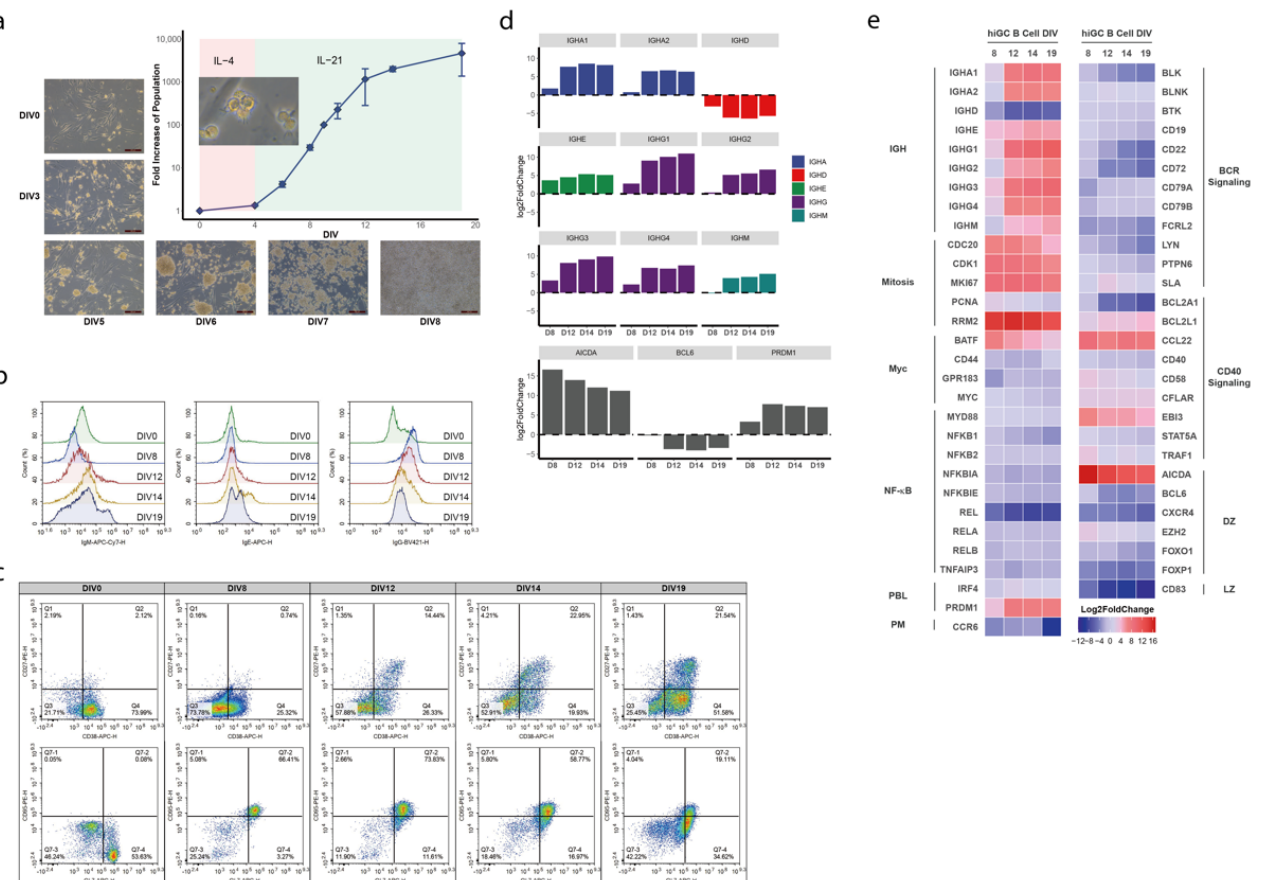
Figure 1. Phenotypic and molecular characterizations of the hiGC culture. ( a ) Growth curve and microscopic images of human in-vitro germinal center (hiGC) B cells co-cultured on the MRC40LB feeder layer. In the first phase of culture (days in vitro (DIV) 0–4), only IL-4 was added; the second phase of culture (DIV4-19) included additional IL-21 in the medium. The insert image in the growth curve plot is a 40× magnification of hiGC B cells exhibiting typical morphological changes upon activation. ( b ) Flow cytometry (FCM) plots showing the increase of IgM+, IgE+, and IgG+ cell populations. ( c ) FCM results showing the increase of CD27+/CD38+ and Fas+/GL7+ cell populations. ( d ) Heatmap of transcription levels for key B cell genes as a function of DIV in the hiGC co-culture. All transcription levels were normalized to those of the primary naïve B cells on DIV 0. PM = precursor of memory cell, PBL = plasmablast, DZ = dark zone, LZ = light zone. ( e ) Detailed trends of transcription levels for all Immunoglobulin heavy chain (IGH) isotypes and critical germinal center genes (AICDA, BCL6, and PRDM1).